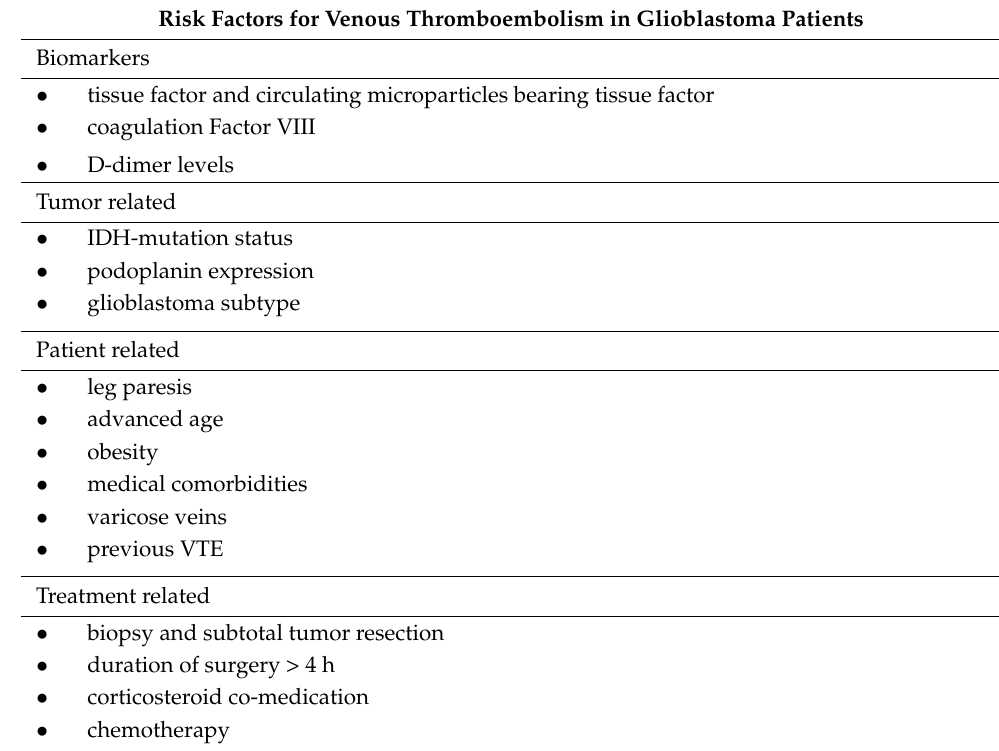
Table 1. Risk factors for venous thromboembolism in glioblastoma